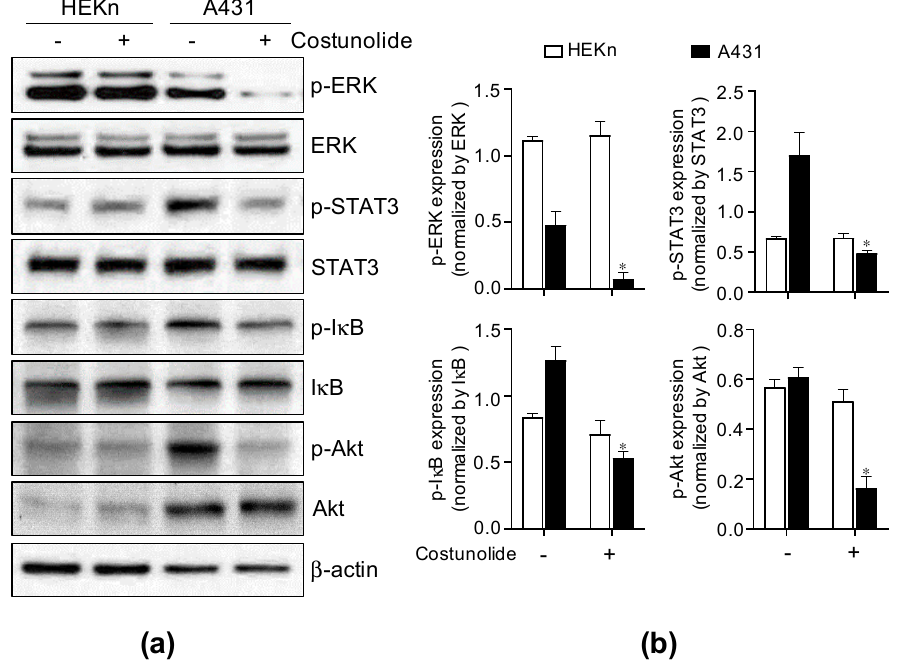
Figure 6. Effect of costunolide on ERK, STAT3, NF- κ B, and Akt activation in HEKn cells and A431 cells. HEKn cells and A431 cells were treated with costunolide (0.8 µ M) for 4 h. Whole cell lysates were harvested. ( a ) The protein levels of p-ERK, ERK, p-STAT3, STAT3, p-I κ B, I κ B, p-Akt, and Akt were evaluated by western blotting. β -actin was used as a loading control. ( b ) Bar graphs display quantification of protein levels normalized by β -actin. * p < 0.05 as compared to vehicle-treated group.